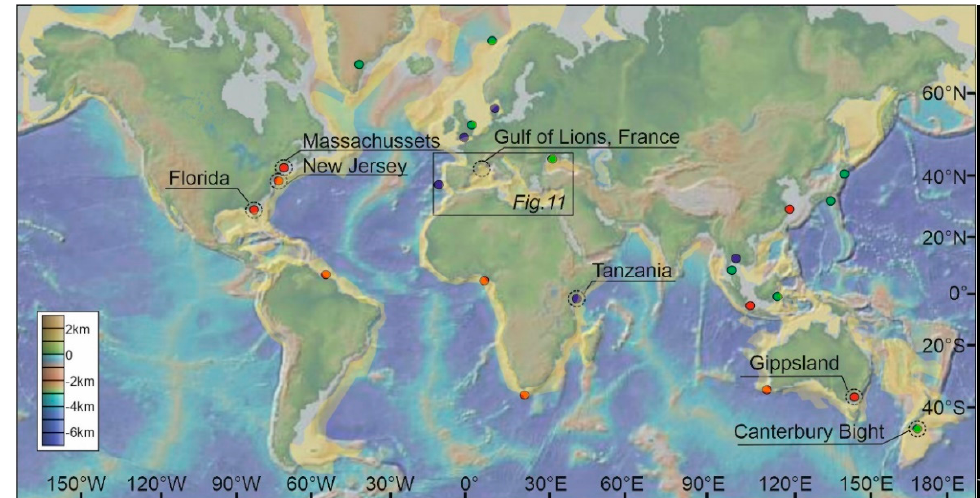
Figure 1. World map showing the distribution of vast meteoric offshore groundwater reserves (modified from Reference [4]), with case studies shown in this paper. In red: reserves proven by observational data, in green: reserves with brackish component highlighted by pore water analysis, in blue: significant meteoric offshore groundwater with indirect evidence based on onshore paleo-groundwater [4]. In black dashed circles: case studies that use offshore geophysical data for groundwater analysis and are described in this paper. The yellow transparent overlay shows the highest density coverage of seismic reflection data, mostly from industry-funded and confidentiality protected sources. This map only provides an approximation of data distribution and it represents a sub-set of data globally acquired (source: https://www.globalseismiclibrary.com/, https://pwdatalibraries.maps.arcgis.com/).